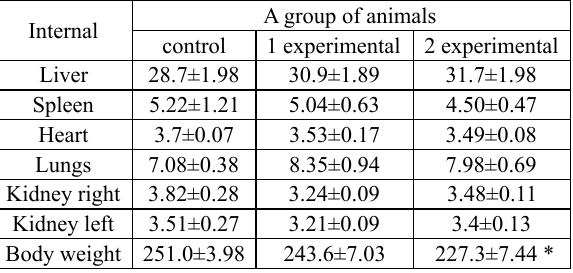
Coefficients of internal organs of laboratory rats after application of the compound ( M ± m , n =6)